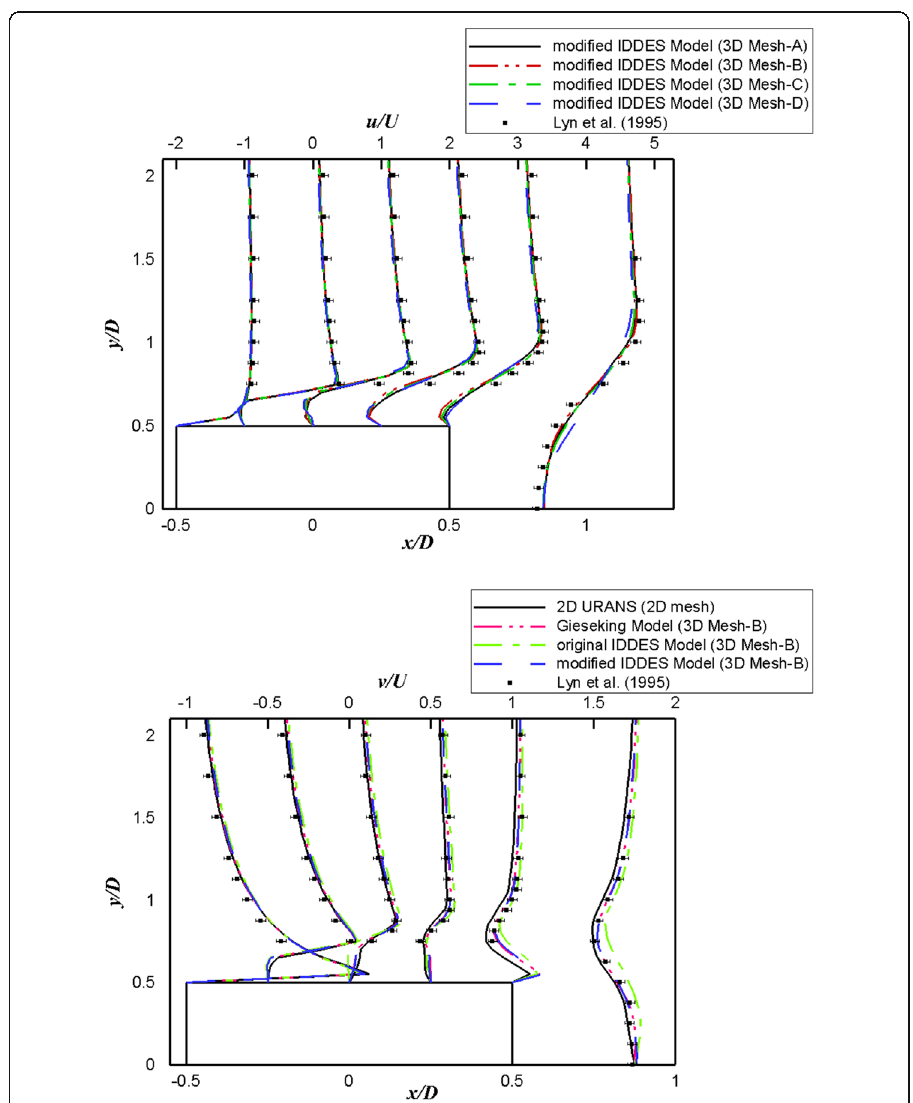
Fig. 3 Mean streamwise (top) and cross-stream (bottom) velocity profiles at different locations near the cylinder predicted by simulations with URANS model and 3D